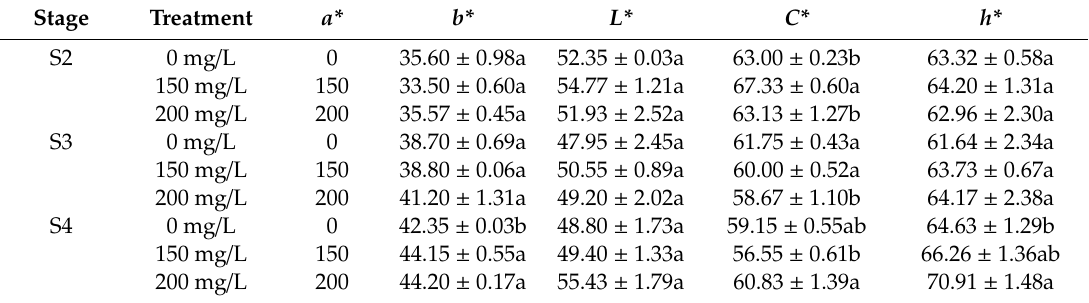
Table 1. Phenotype parameters of ‘Yanhonggui’ receiving di ff erent concentrations of ABA